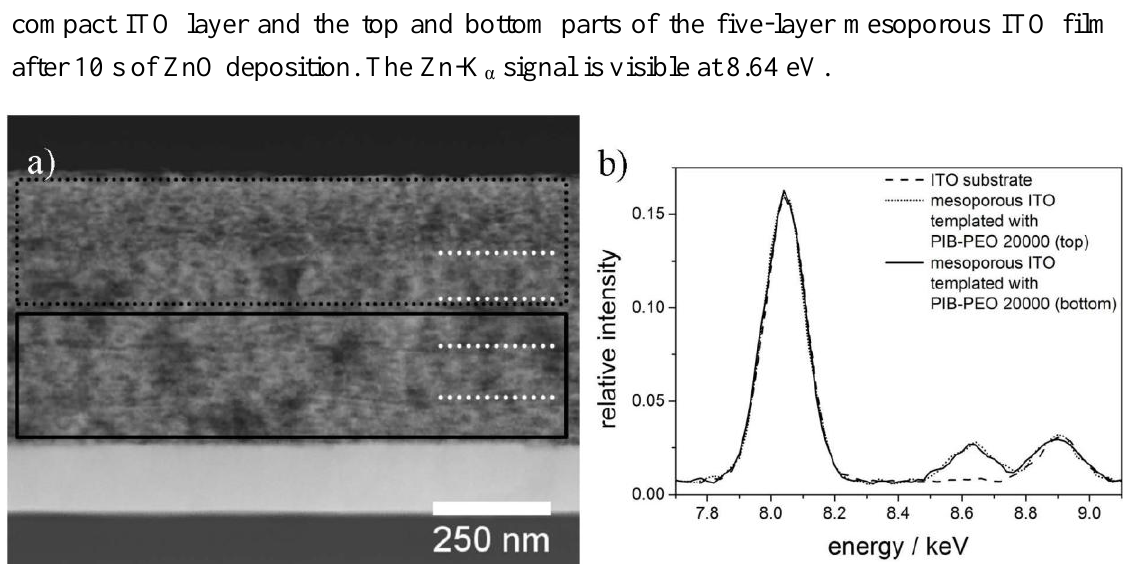
Figure 7. ( a ) Scanning mode (STEM) dark field image of a five-layer mesoporous ITO film prepared with the block copolymer PIB-PEO 20000 in cross section), the dotted